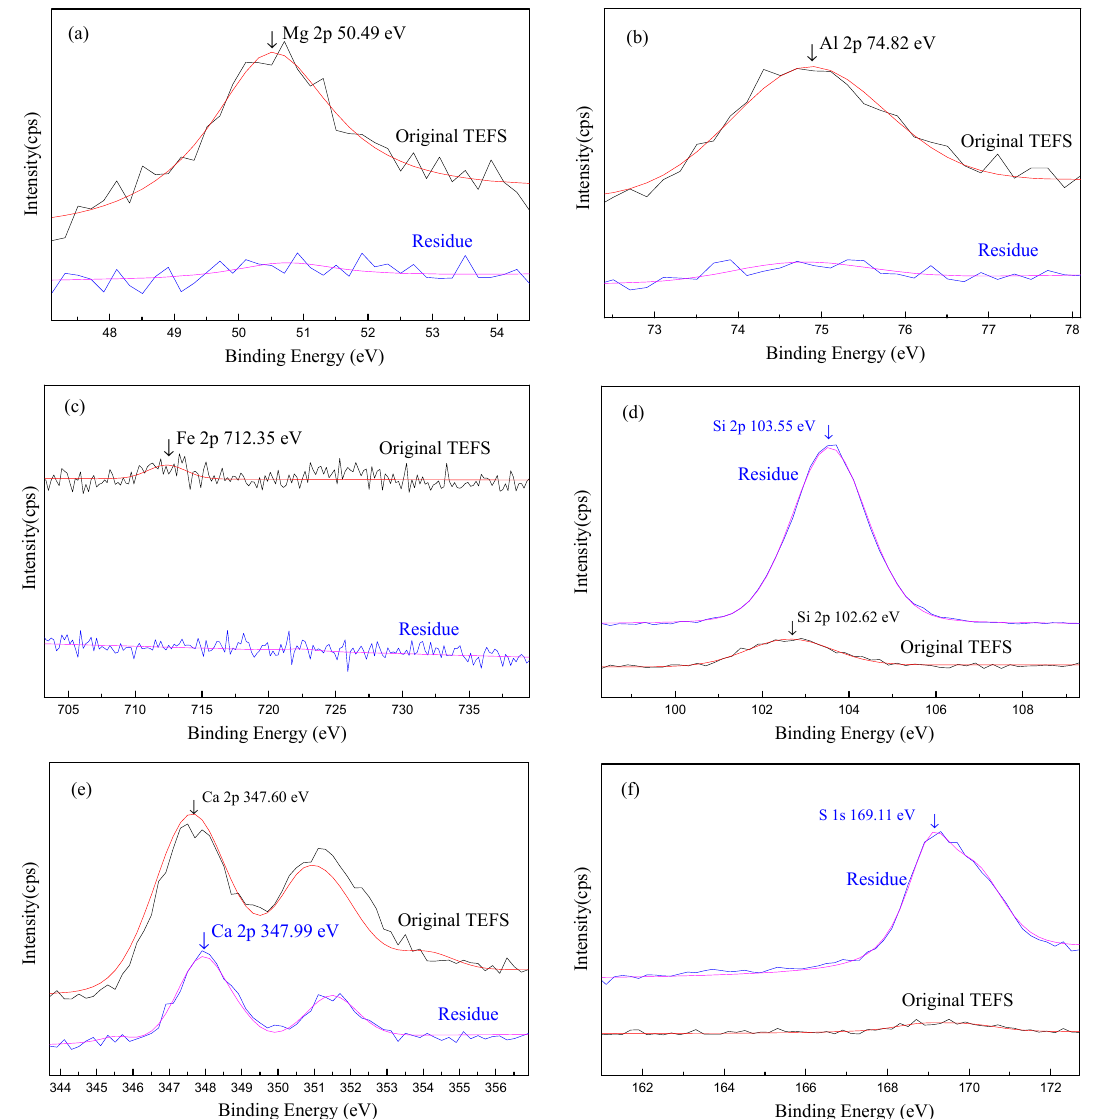
Figure 13. FESEM images showing the morphologies of original TEFS ( a , b ), acidolysis products ( c , d ), and water leaching residues ( e , f ).